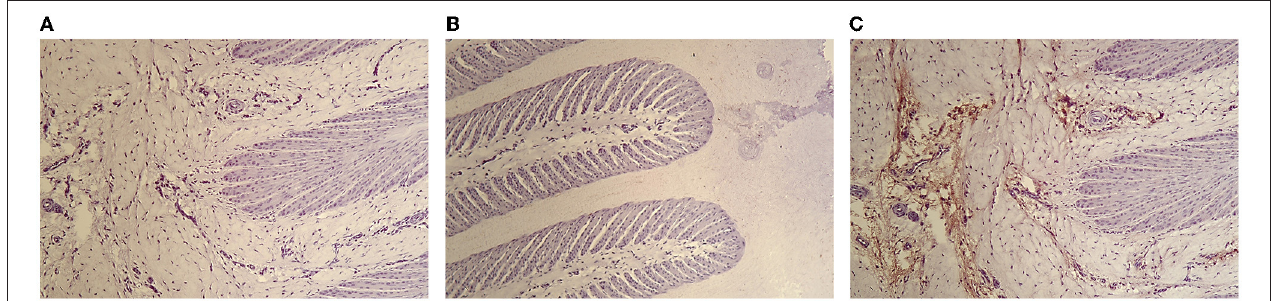
FIGURE 1 | Photomicrograph of the hoof lamellae of a control horse HE staining without primary MPO antibody (A,B) and HE staining with complete MPO immunohistochemical protocol (C) ( × 100).